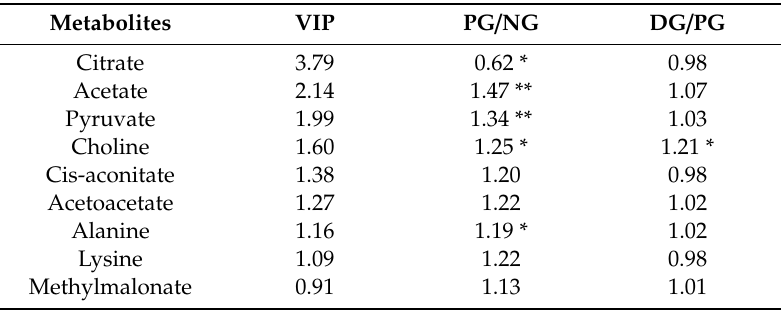
Table 5. Potential marker in rat urine and their variations between groups.